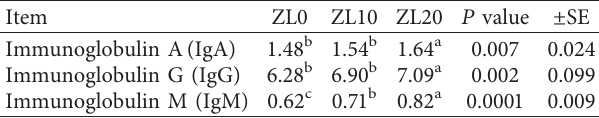
Table 5: Effects of dietary ZL supplementation on the immune response of growing